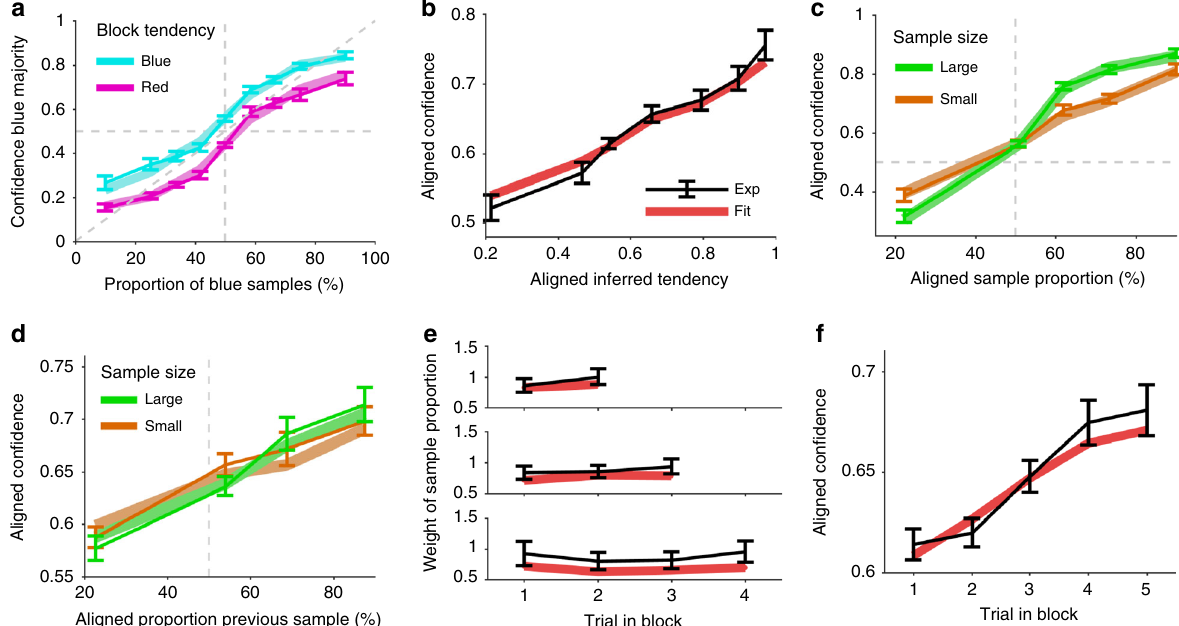
Fig. 8 Patterns for fi tted block tendency. Behavioral patterns in the hierarchical inference task (Experiment 2) compared to a fi tted model assuming a mismatched block tendency and a sigmoidal response mapping accounting for distortions on the response. The fi ts of this model closely reproduce the patterns produced by participants. Error bars indicate SEM across